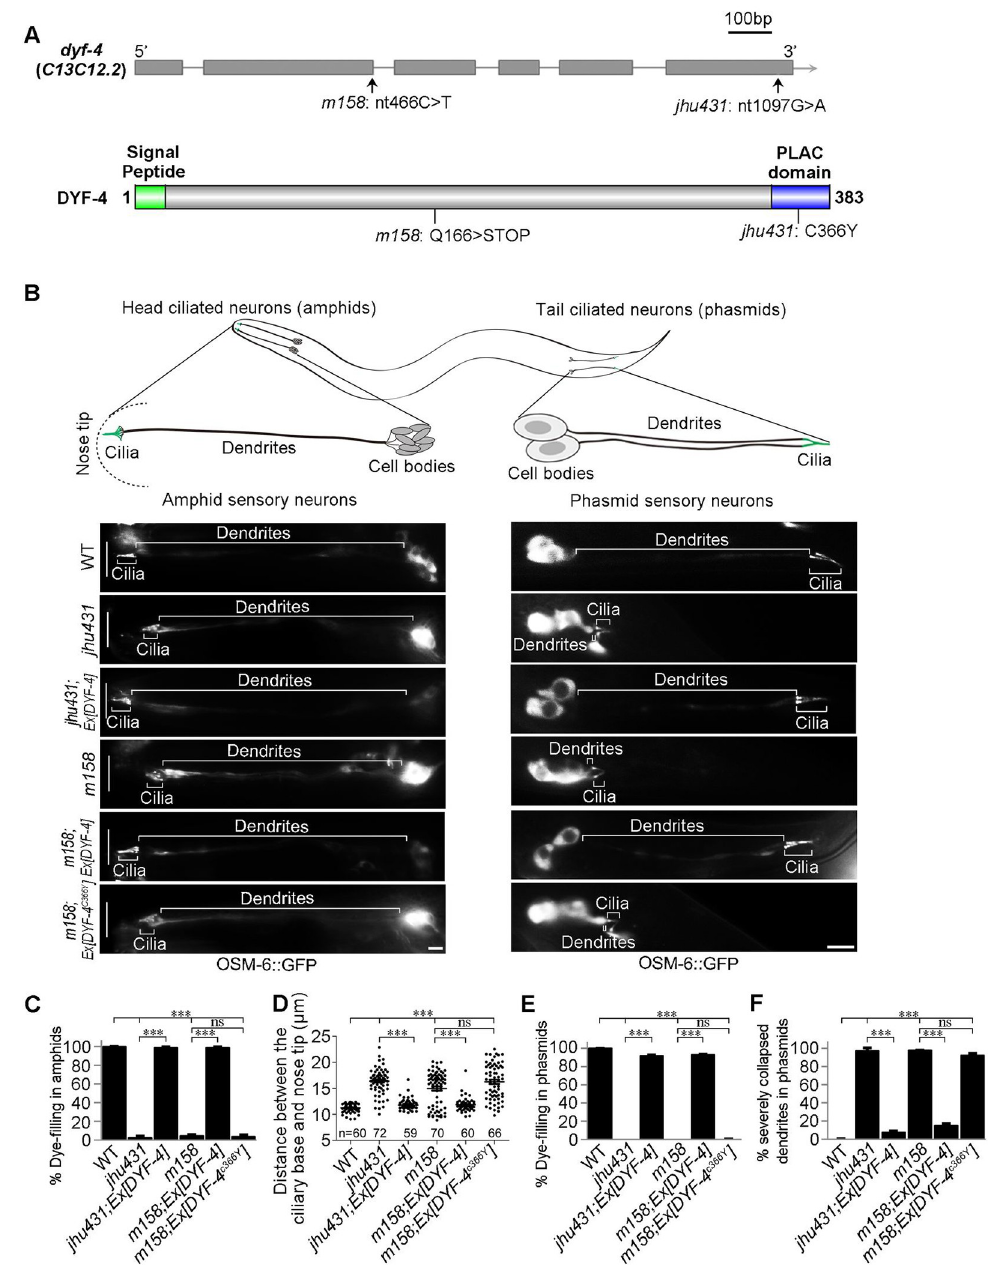
Fig 1. dyf-4 encodes C13C12 . 2 and is required for dendrite extension in C . elegans . (A) Schematic diagrams of the genomic and protein structures of dyf-4 ( c13c12 . 2) . DYF-4 has a predicted signal peptide at its N-terminus and a PLAC domain at its C-terminus. dyf-4 ( jhu431) carries a point mutation (c.1097G > A) that leads to a missense mutation in one of the conserved cysteines (C366Y) in the PLAC domain. dyf-4 ( m158) possesses a point mutation (c.466C > T) that results in a nonsense mutation (Q166stop) in the middle region of the DYF-4 protein. As dyf-4 ( jhu431) and dyf-4 ( m158) exhibit the same mutant phenotypes, we used the dyf-4 ( m158) mutant in subsequent experiments if not otherwise specified. (B) Upper panels: schematic representation of C . elegans amphid and phasmid structures. Lower panels: Fluorescence micrographs of sensory neurons in the amphid and phasmid in adult WT, dyf-4 ( jhu431) , jhu431 ; Ex [DYF-4] , dyf-4 ( m158 ), m158 ; Ex [DYF-4] and m158 ; Ex [DYF-4 C366Y ] worms. The IFT-B component OSM-6::GFP was used to label cell bodies, dendrites and cilia. The white vertical line at left represents the nose tip position. Scale bars: 5 μ m. (C) Statistics of the dye-filling percentages in the amphids of the indicated worm lines. (D) Statistics of the distance between basal bodies and the nose tip at the head of the indicated worm lines. (E) Statistics of the dye-filling percentages in the phasmids of the indicated worm lines. (F) Statistics of the ratio of phasmids with severely collapsed dendrites in the indicated worm lines.